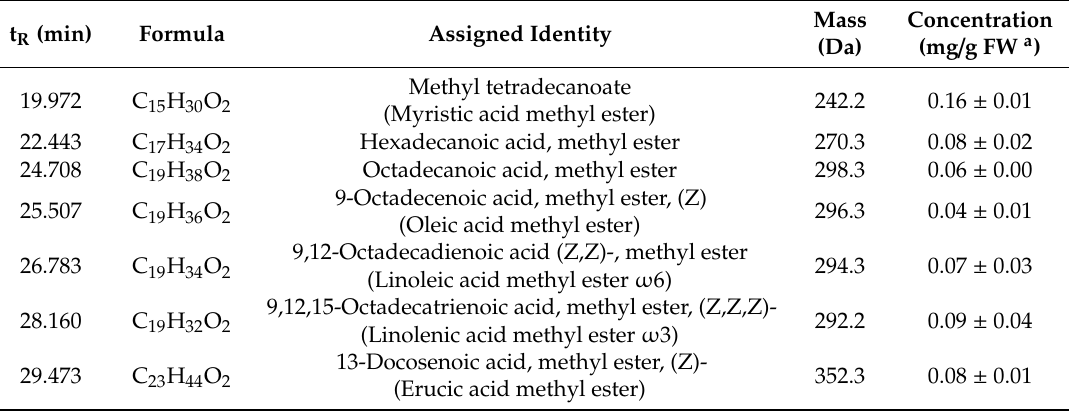
Table 2. Fatty acids profile of calafate fruit